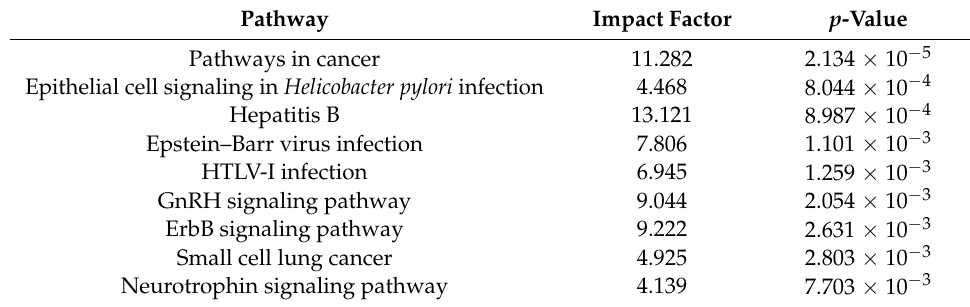
Table 1. Enriched pathways for BRCA driver module ( GATA3 , ZNF703 , CDH1 , MAP3K1 , FH , MAP2K4 , LYZ , GFOD1 , and CDKN1B ) performed by MITHrIL using standard KEGG pathways. The pathways are sorted by p -value, and only the pathways with p -value < 0.01 are